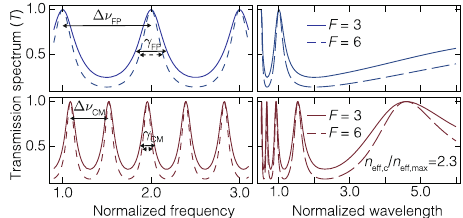
Fig. 2 | The spectral properties of cascaded-mode resonances. The spectra of a traditional resonator compared with the spectra of a cascaded-mode resonator versusfrequency(left)orwavelength(right).Theblueandredspectrarespectively correspond to conventional resonators and cascaded-mode resonators with = n : 3, ϕ : 5 π . The solid and dashed lines correspond to a reso- n eff,c eff,max =2 r,tot =1 nator ’ s fi nesseequalto3and6,respectively.Notethereductionofthefreespectral range Δ ν and linewidth γ when several transverse modes are